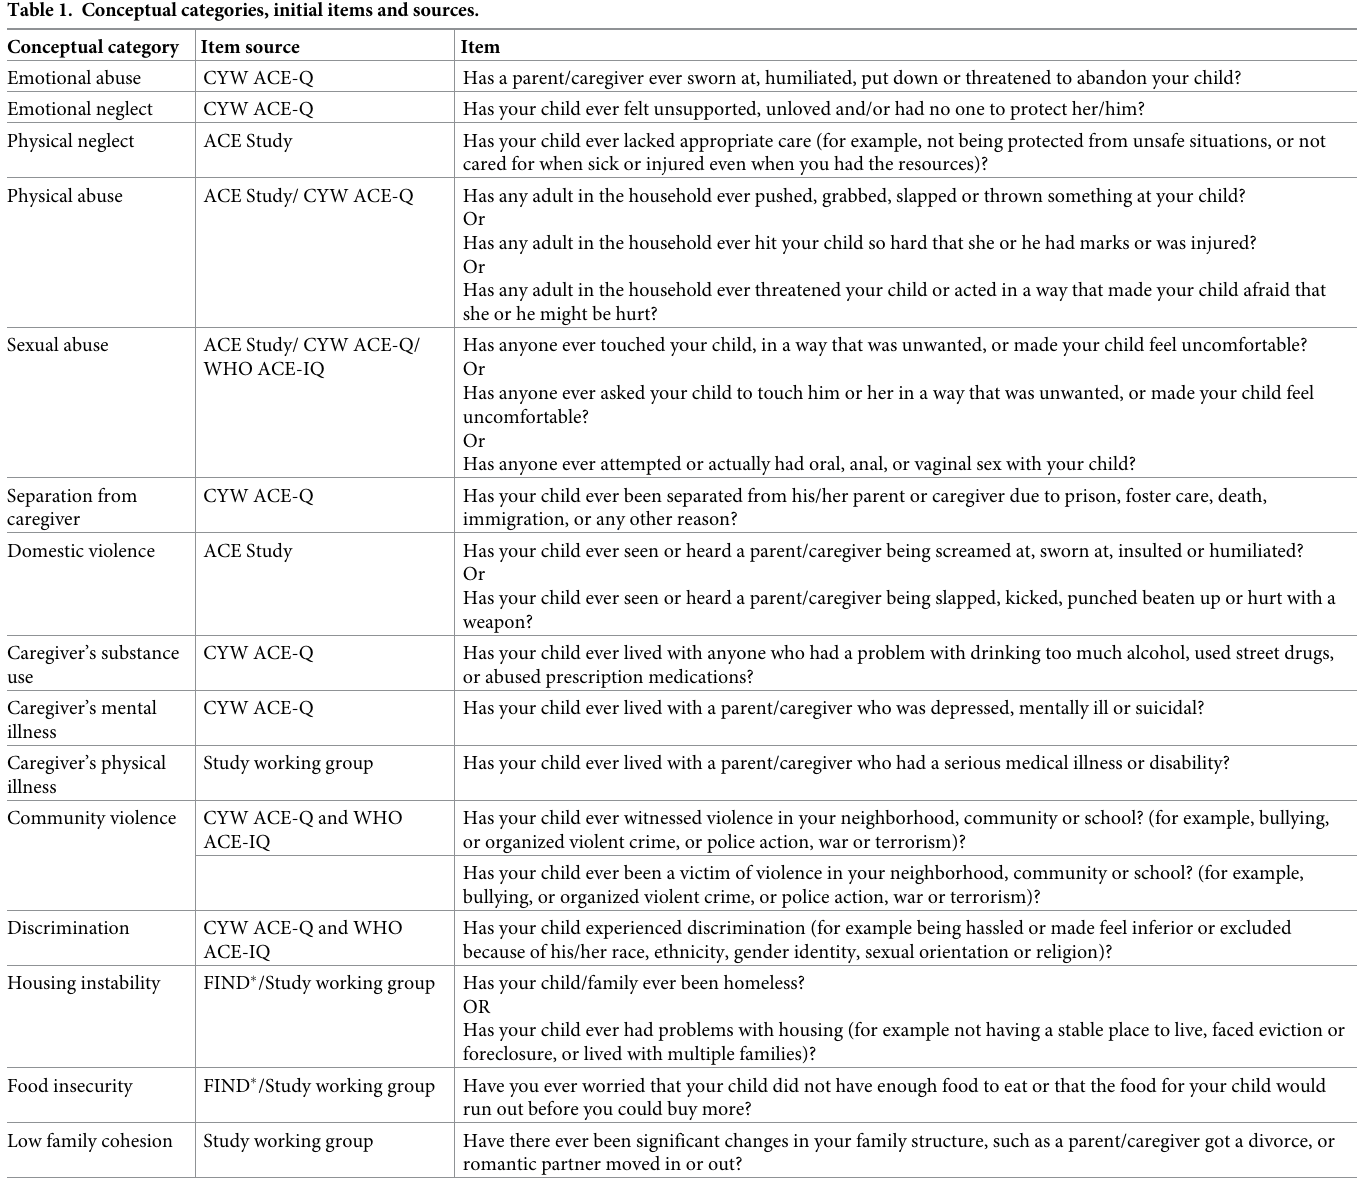
Table 1. Conceptual categories, initial items and sources. Conceptual category Item